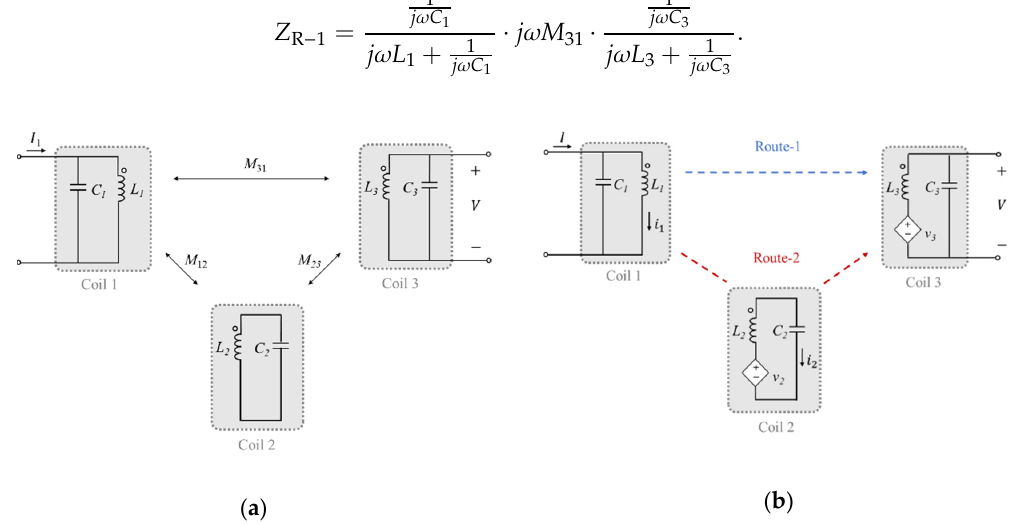
Figure 4. The equivalent circuit model: ( a ) Three coils with ideal mutual inductances; and ( b ) with two routes.